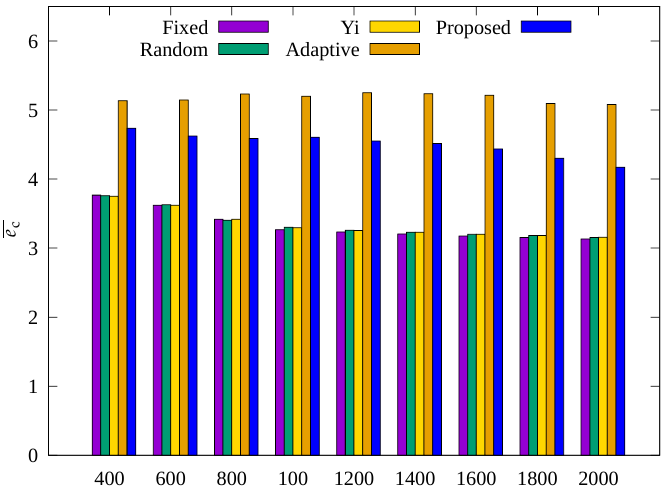
Figure 12. Comparison of the average amount of consumed energy according to the number of nodes.